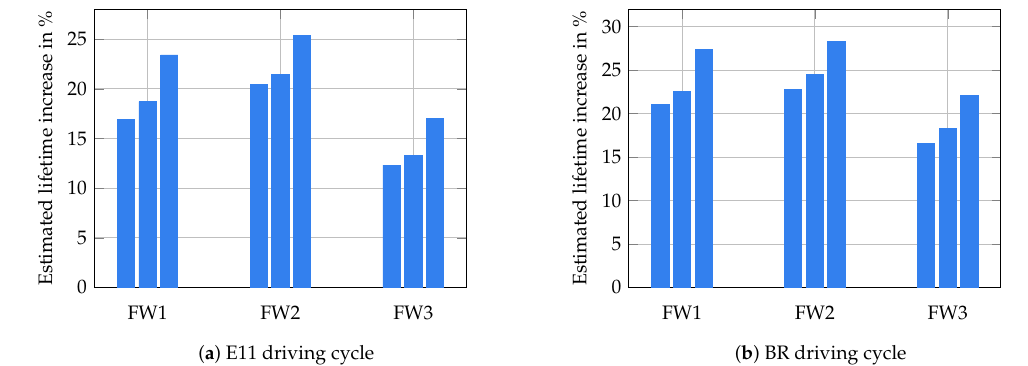
Figure 9. Battery life increase for KESS configurations (left: RB1, middle: RB2, right: NMPC).